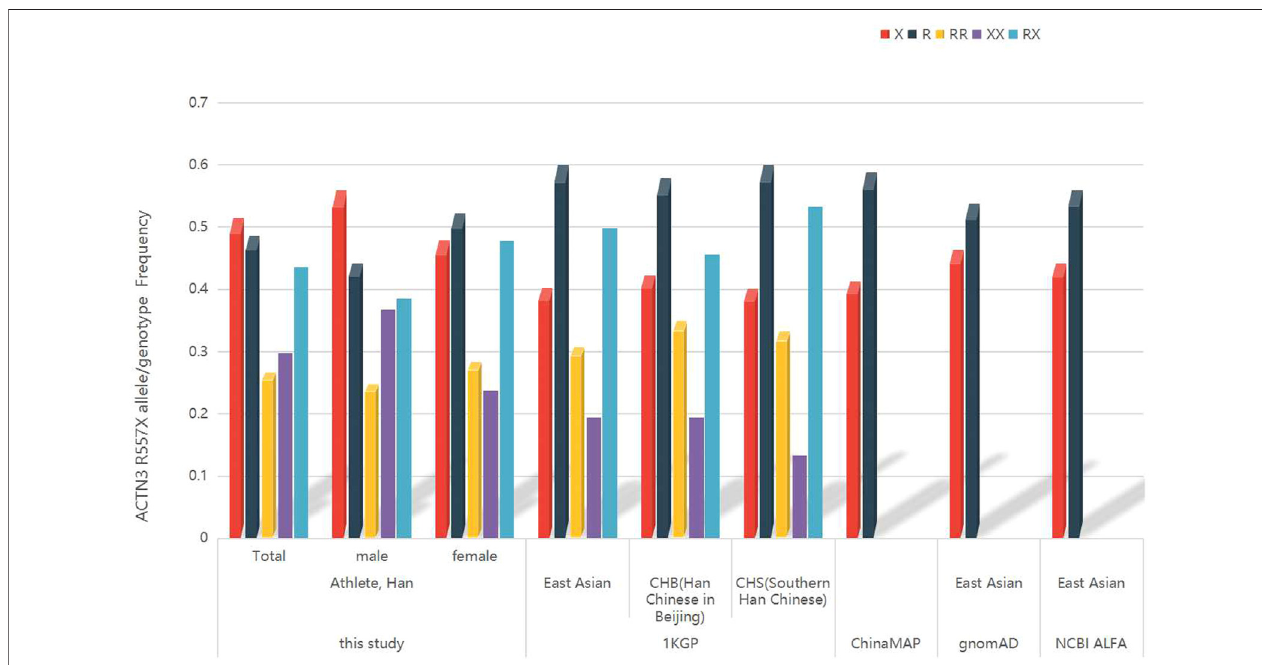
FIGURE 3 | The frequency of ACTN3 R577X allele/genotype in rowing athletes in China, Chinese population from the ChinaMAP, East Asian, Han Chinese in Beijing, and Southern Han Chinese populations from 1KGP, East Asian population from gnomAD, and NCBI ALFA.